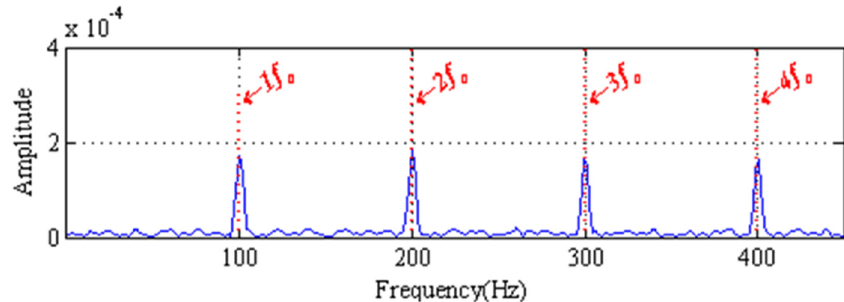
Figure 7. The results of the proposed method.